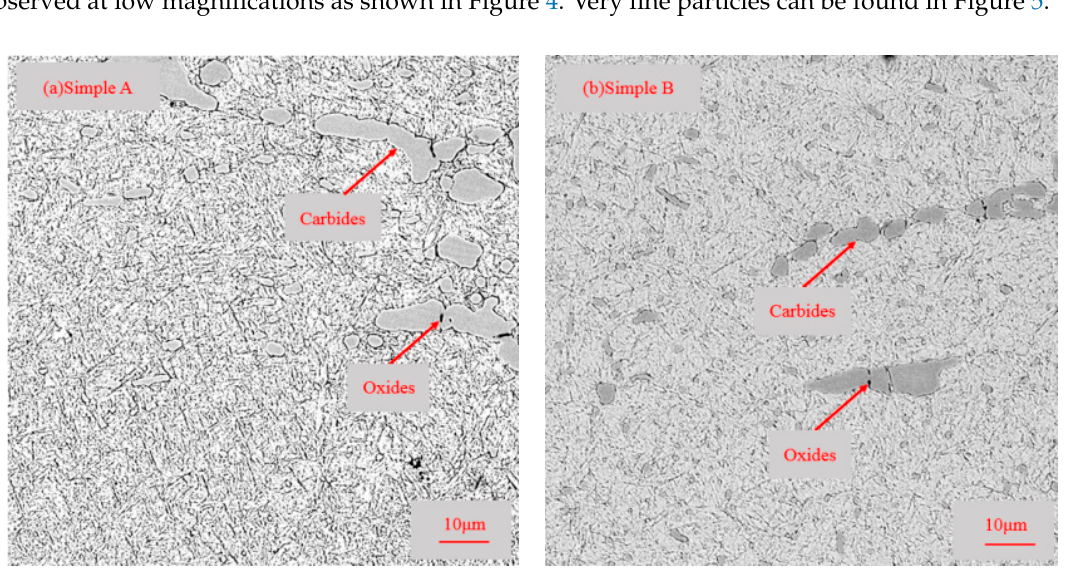
Figure 5. Carbides and oxides SEM morphology: ( a ) sample A, ( b ) sample B.